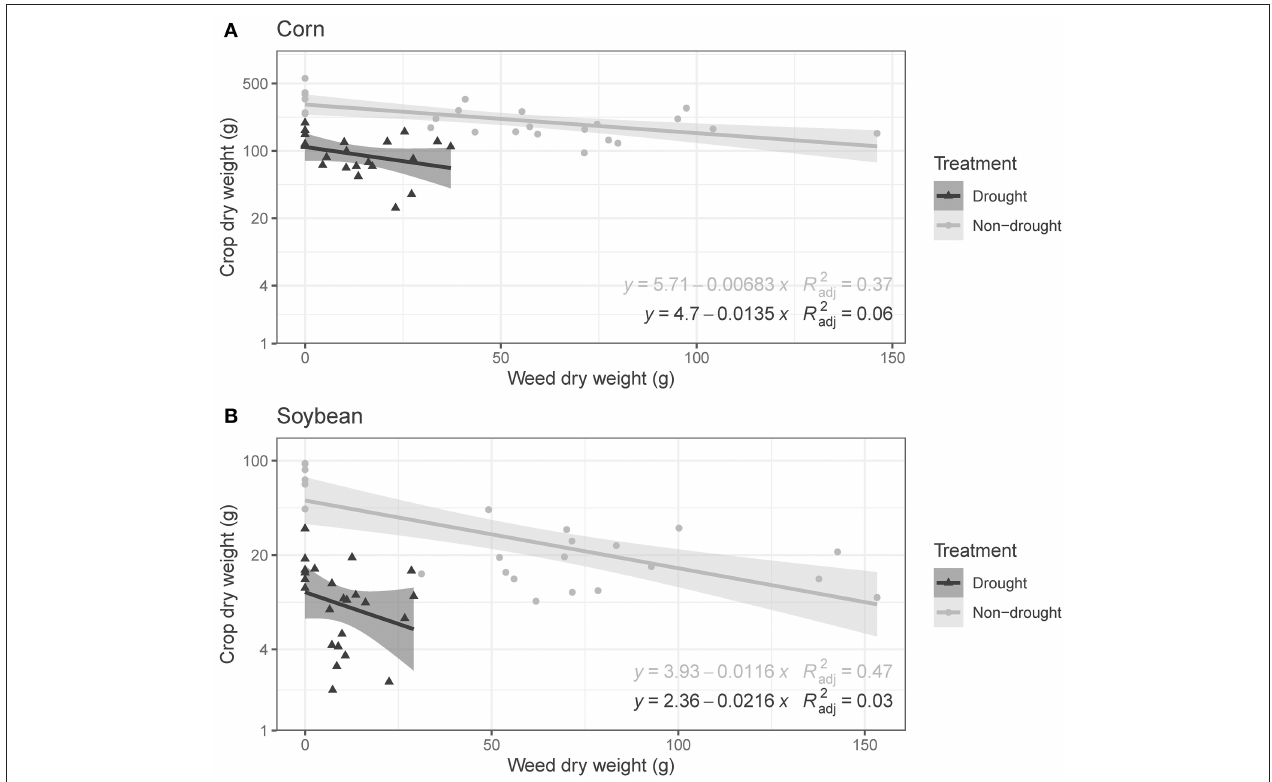
FIGURE 2 | Effects of drought treatment and ivyleaf morningglory (IMG) biomass on crop biomass under greenhouse conditions. Data are presented for (A) corn and (B) soybean. Fitted lines represent linear regressions with 95% confidence intervals (drought in black and non-drought in gray). In regression equations, x is IMG biomass and y is the natural log of crop